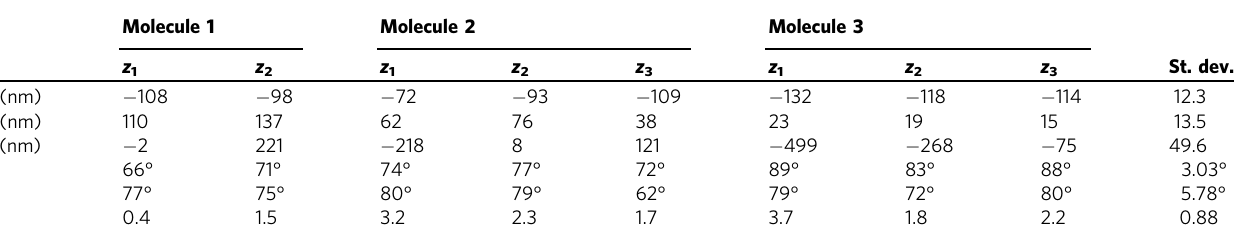
Table 1 Retrieved positions, orientations, and wobble angle for the fl uorescent molecules in Fig. 7a, b.